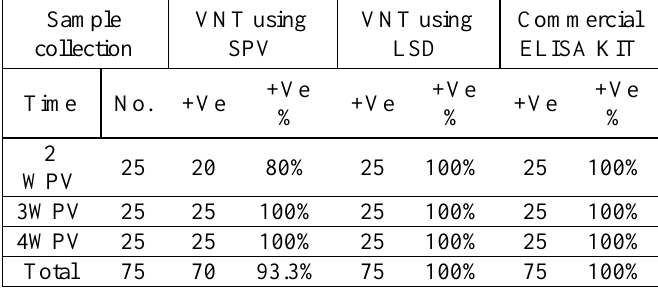
Table 2: Detection of antibodies in vaccinated calves Sample collection